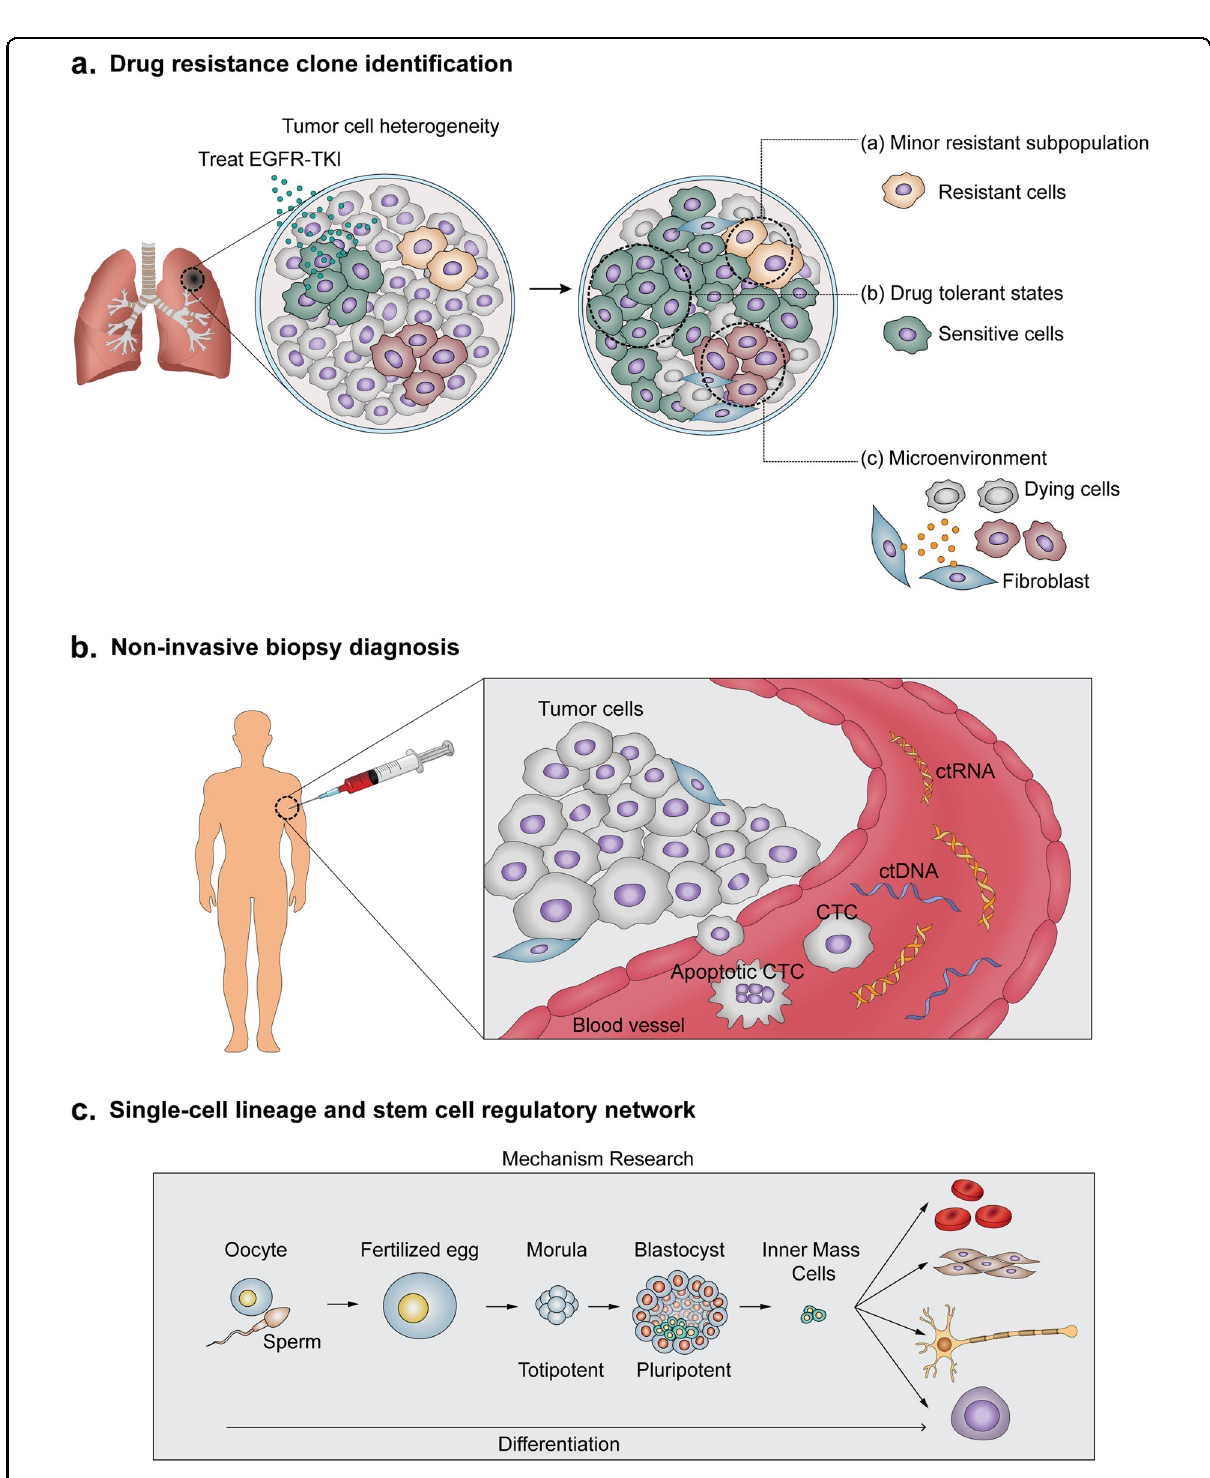
Fig. 6 Many facets of scRNA-seq applications. a Intratumor heterogeneity poses challenges in cancer genomics. scRNA-seq can tackle this problem by effectively identifying subgroups based on responsiveness in various contexts. b Liquid biopsy provides exciting opportunities, and scRNA-seq of CTCs could provide novel insights into biomarker characterization. c scRNA-seq can infer lineage information from the early developmental stage and can identify novel differential